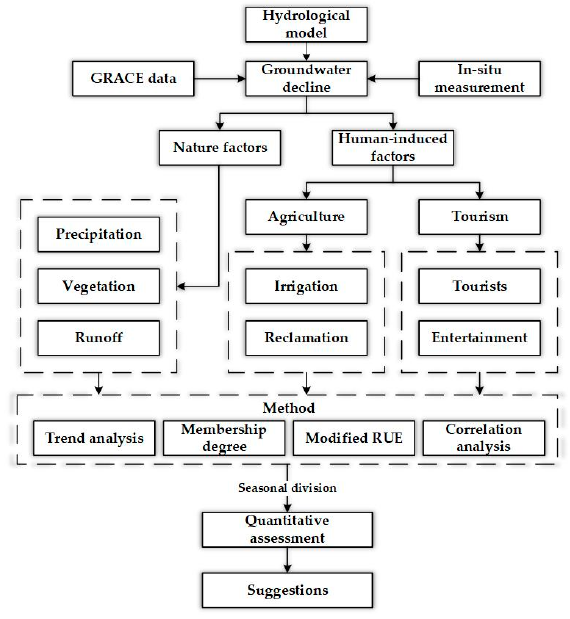
Figure 2. Study flowchart of the groundwater decline in the BS region. GRACE: Gravity Recovery and Climate Experiment. RUE: rain use efficiency.